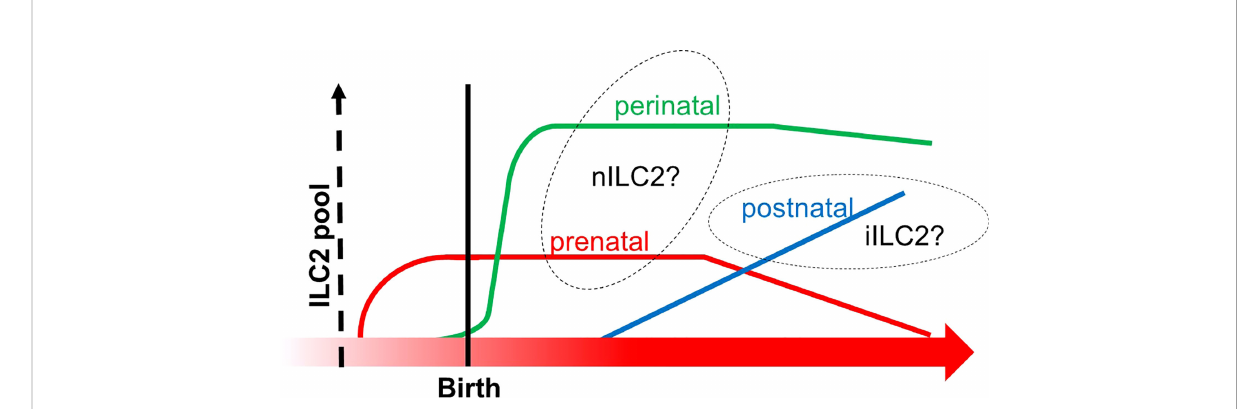
FIGURE 6 The transition of ILC2 pools from prenatal to postnatal phases. The X-axis indicates the developmental chronology, and the Y-axis shows the cellularity of the ILC2 pool. Three subgroups of ILC2 pools are depicted (prenatal in red, perinatal in green, and postnatal in blue). Prenatal and perinatal subgroups might be derived from the thymus since they increased before the bone marrow fully commenced hematopoiesis in the postnatal phase. This graph was created based on ref